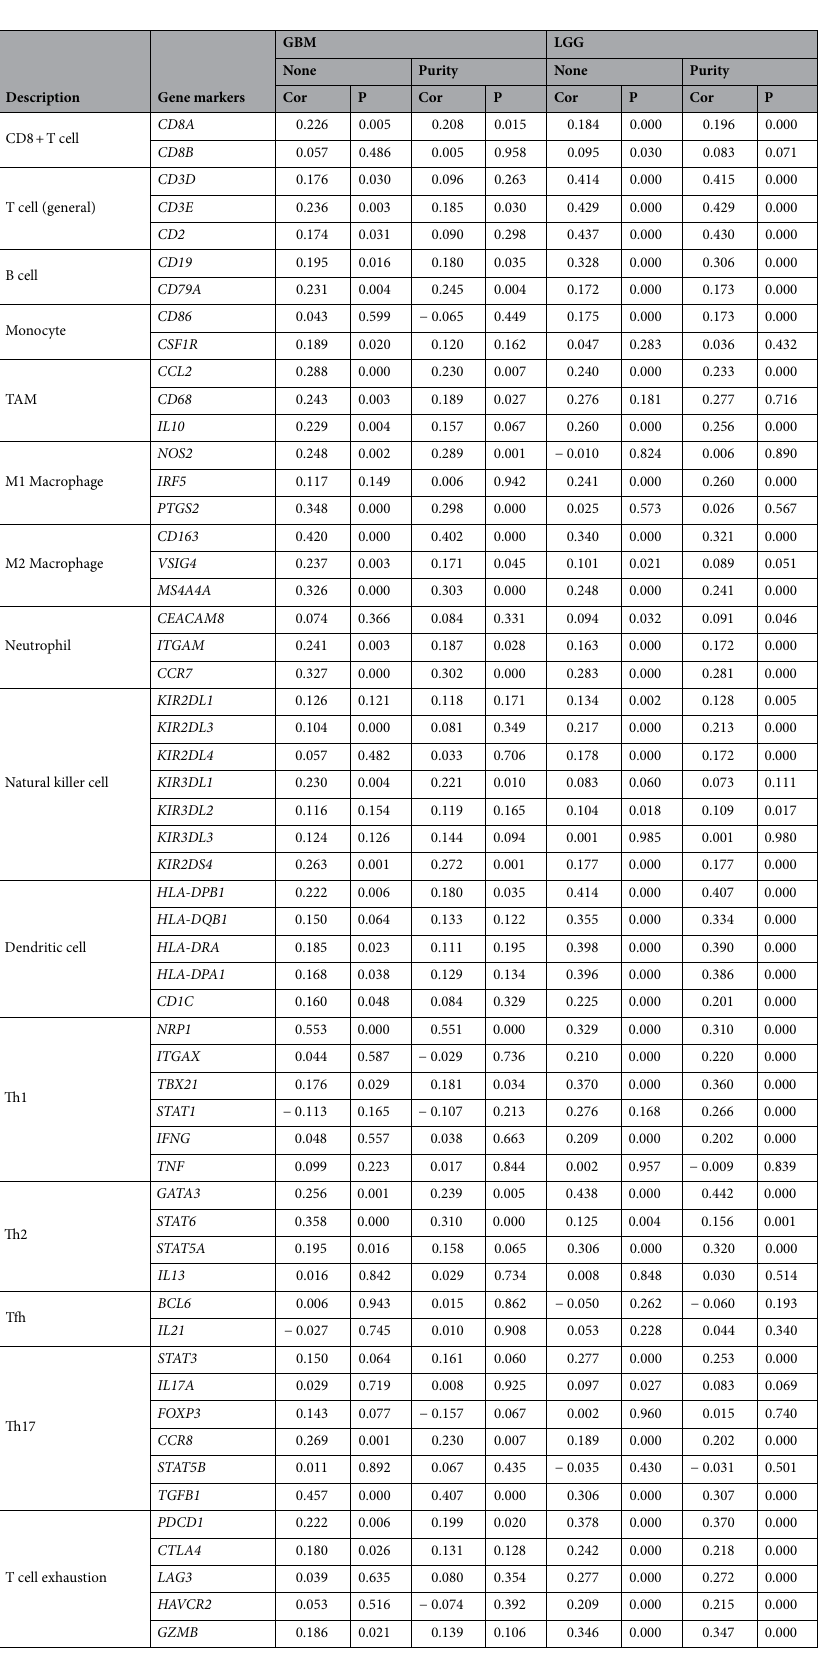
Table 1. Correlation analysis between PCOLCE and related genes and markers of immune cells in